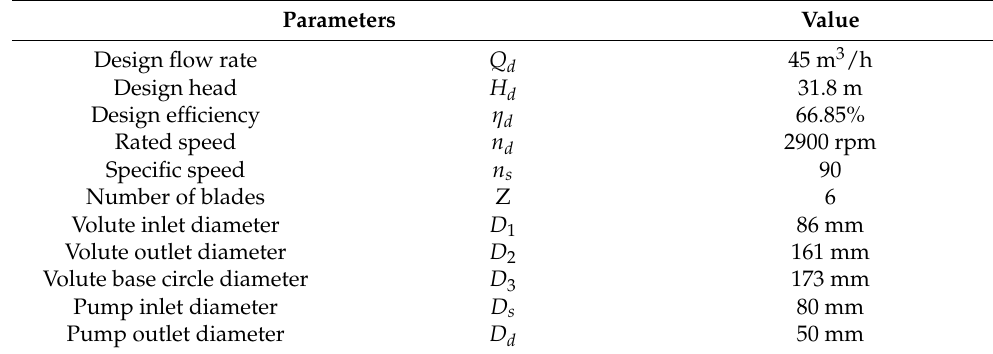
Table 1. Basic parameters of the centrifugal pump.